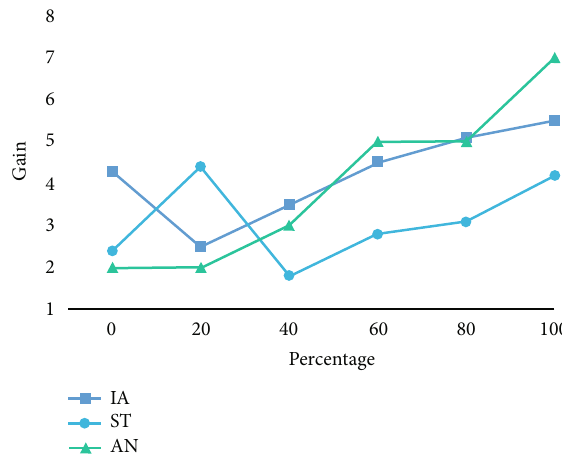
Figure 4: Income chart of three Bayesian network